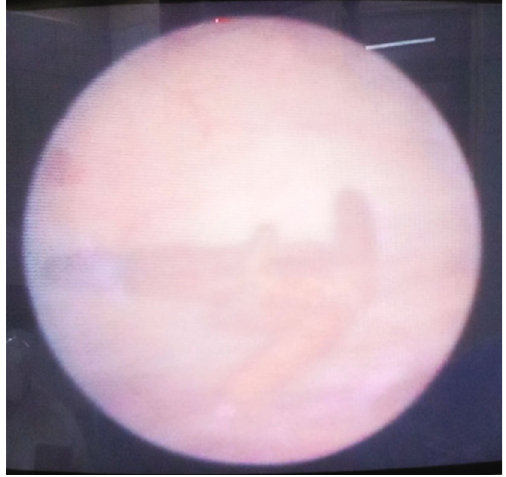
Figure 2: Cystoscopic vision of the intrauterine device with no damage to the bladder wall.